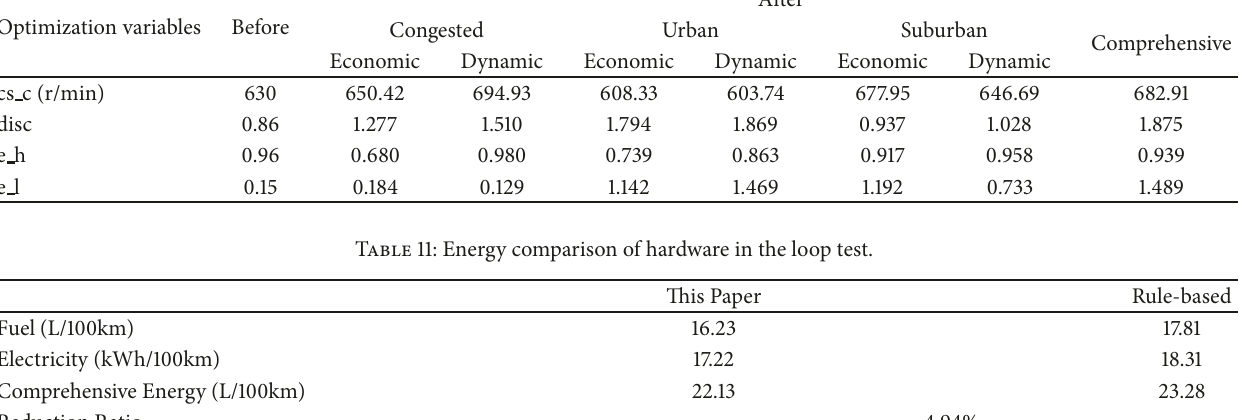
Table 10: The change of vehicle control strategy parameters before and after the optimization of various conditions. After Optimization variables Before Congested Urban